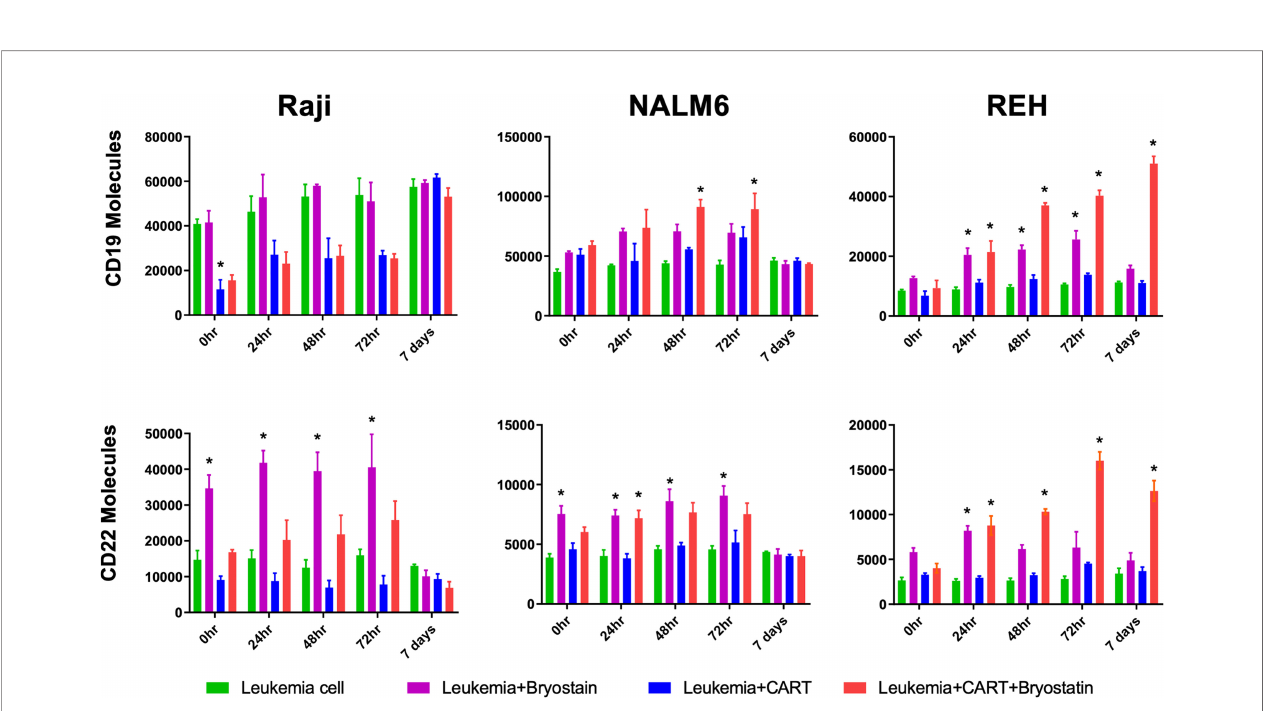
FIGURE 4 | Surface expression of CD19 and CD22 following bryostatin wash-out and CAR-T removal. After overnight culture with anti-CD22 CAR-T, the number of cell surface proteins was quanti fi ed using Quanti-Brite analysis, average of triplicate wells and standard deviations are shown. 0 hr, x-axis, is after the overnight culture, and each time point represents cell surface proteins on the surface of untreated Raji, NALM6, or REH (Leukemia cell, green bars), treated with bryostatin alone (Leukemia + Bryostatin, magenta bars), treated with CAR-T alone (Leukemia+CART, blue bars), or treated with both CAR-T and bryostatin (Leukemia+CART +Bryostatin, red bars), at the time points listed, x-axis. Signi fi cant differences from leukemia alone are shown *p <